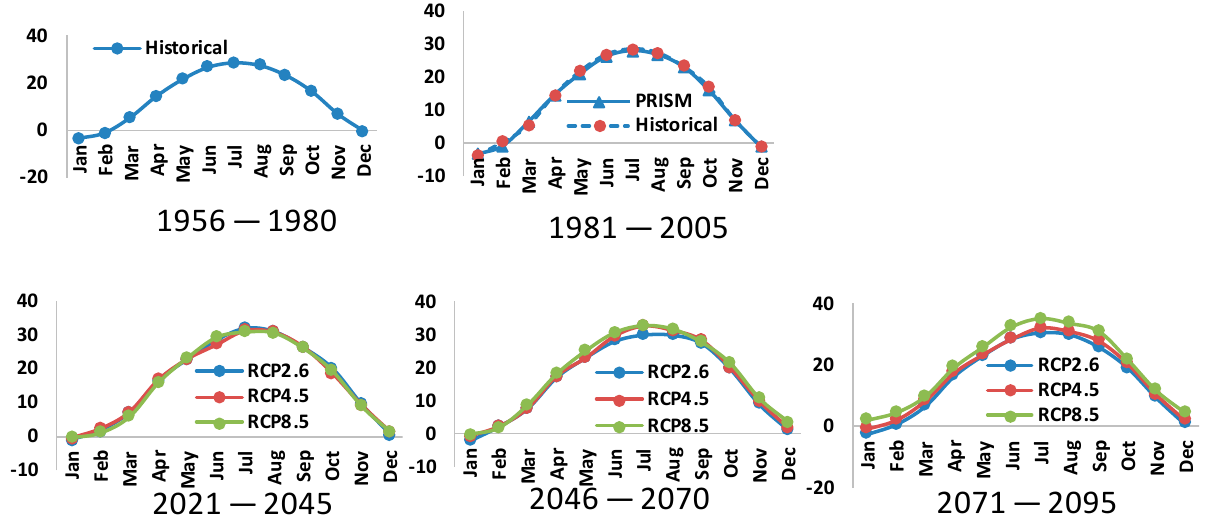
Figure 2. Trends in monthly average maximum temperature (°C) patterns for each climate scenario.